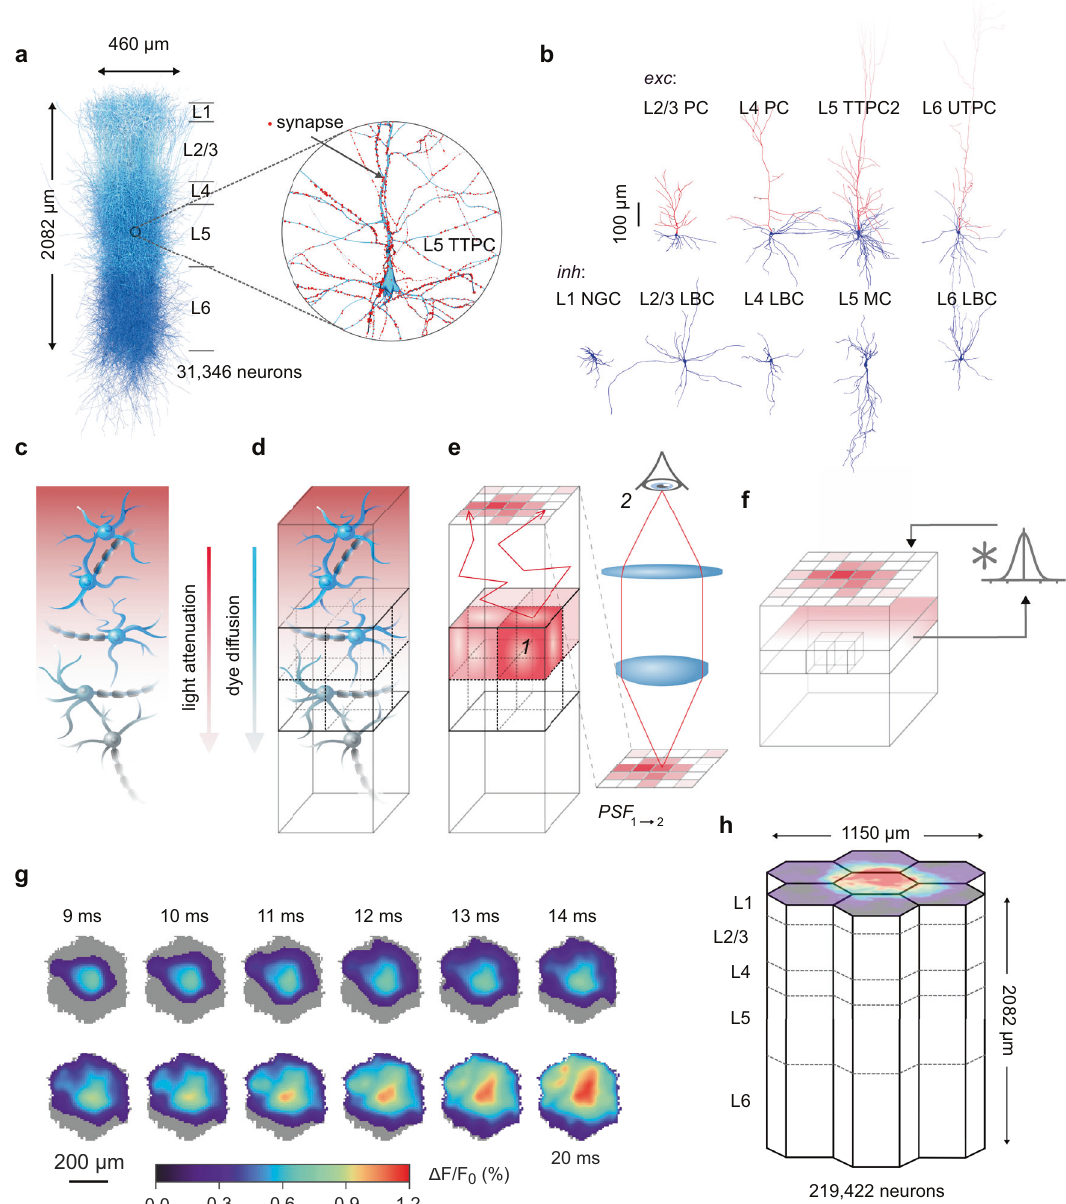
Fig. 1 Cortical microcircuit overview and in silico VSDI work fl ow. a Digital microcircuit comprising 31,346 morphologically detailed neurons connected in a columnar unit. Inset: expanded view of a L5 PC, with synapses highlighted in red. b Exemplar excitatory (top) and inhibitory (bottom) cell types. Blue: axons. Red: dendrites. c – f Schematic illustrating the in silico VSDI work fl ow. c Neuron surface areas are scaled by prefactors accounting for dye diffusion and light transport in cortical tissue. d Microcircuit volume is divided into voxels to facilitate calculations. e Photons emitted from each voxel are scattered and absorbed throughout the tissue volume via Monte Carlo simulations. Photons reaching the cortical surface are propagated through a tandem-lens optical setup using ray transfer matrix analysis. Steps e and f are performed once for a given circuit and optical setup to determine a depth-dependent point-spread function (point-spread from 1 to 2 in panel e , i.e., from voxel to camera). f Raw signals at each depth are convolved with their respective point- spread function, and accumulated in a pixel array at the surface. g Example VSDI image stack for 11 ms of spontaneous activity. Images were thresholded at 10% of peak response. h Microcircuits were aggregated into a larger volume made of a central microcircuit column surrounding by six additional columns contacting each of the central column ’ s hexagonal sides (i.e., the “ mosaic ” ). This arrangement mitigates boundary effects within the central column and facilitates the analysis of signal spread